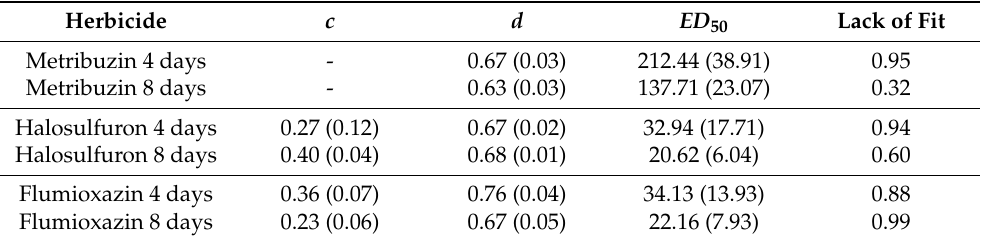
Table 4. Estimated sigmoidal parameters for metribuzin, halosulfuron, and flumioxazin on F v /F m values of potato on days 4 and 8 days after treatment. Standard errors in parentheses.